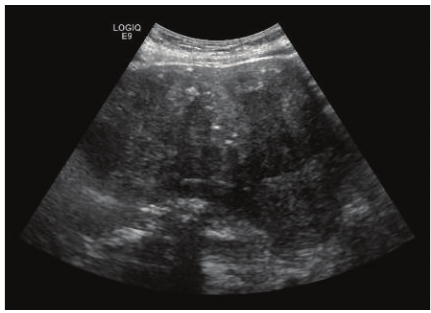
Figure 1: Ultrasound image showing a large pelvic mass.